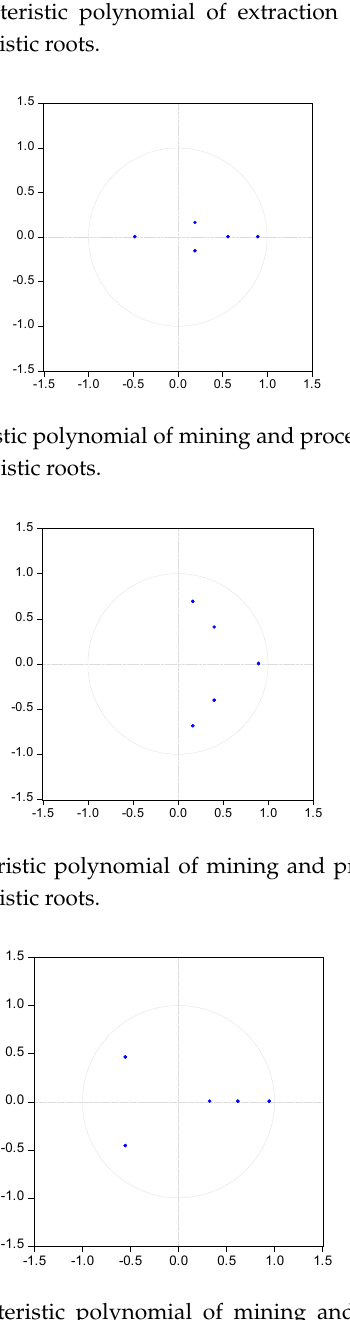
Figure 7. VAR roots of characteristic polynomial of mining and processing of nonmetal ores. Note: blue dots indicate characteristic roots.